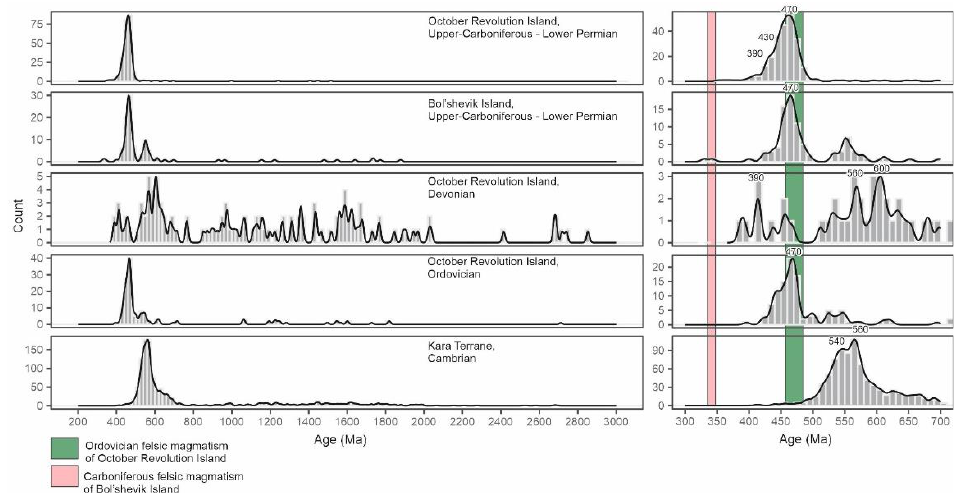
Figure 6. Comparison of detrital zircon age spectra (KDE plots) from Paleozoic strata of the Kara terrane (this study and [2,10,11]). Ages of magmatic events from [15,16]. The combined (U-Th)/He and U-Pb dating of zircons indicates that most zircon ages